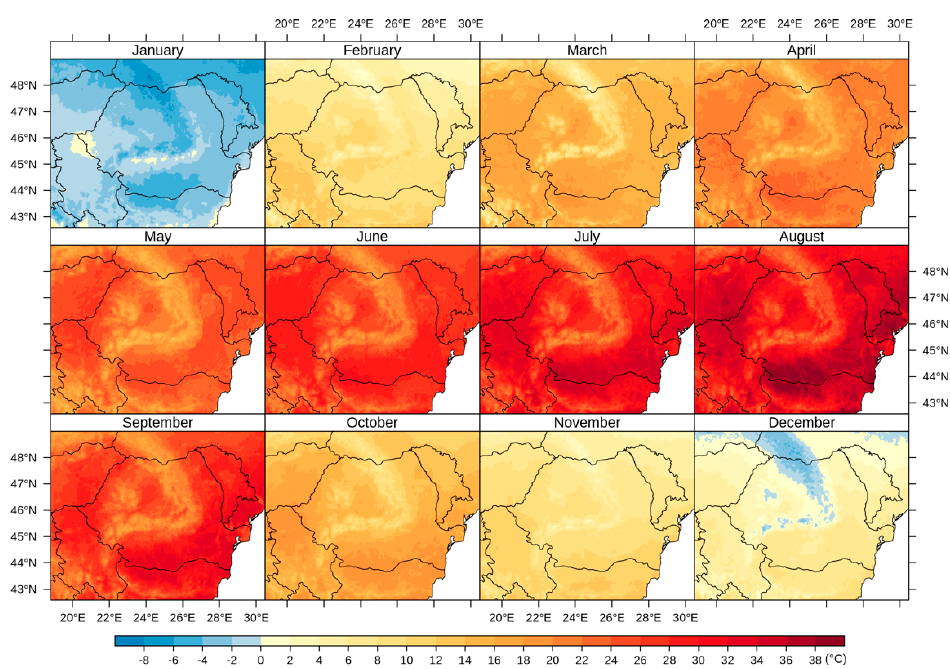
Figure 9. Monthly mean minimum LST (°C) from 2016 to 2017.